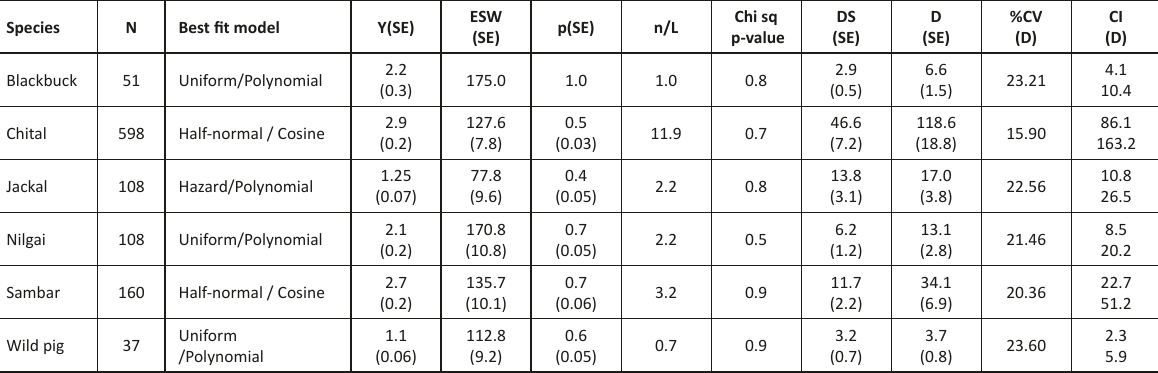
Table 1. Number of detections and density estimates of jackals and ungulates in Van Vihar National Park Bhopal, Madhya